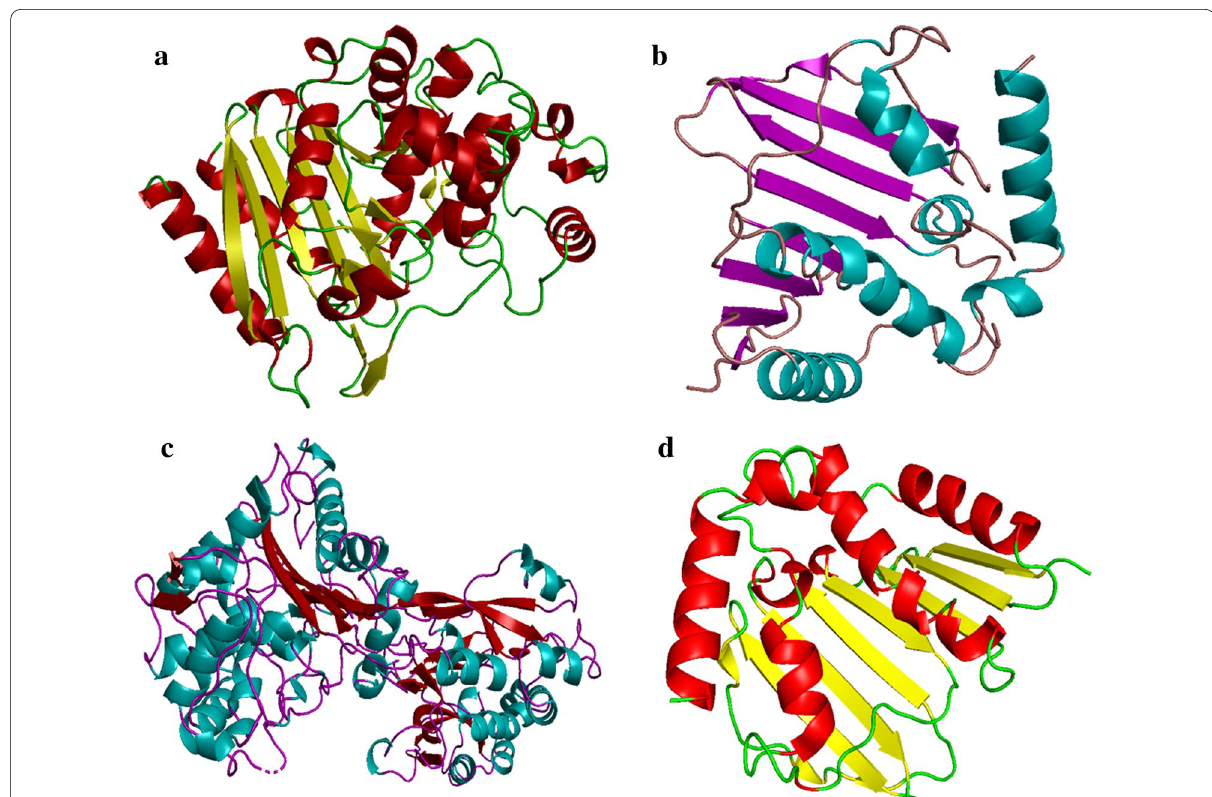
Fig. 4 3D‑structure of a beta lactamase (PDB: 4KZ9), b DNA gyrase (PDB: 6KZX) from E. coli , c beta lactamase (PDB: 1MWU) and d DNA gyrase (PDB: 5CTU) from S.